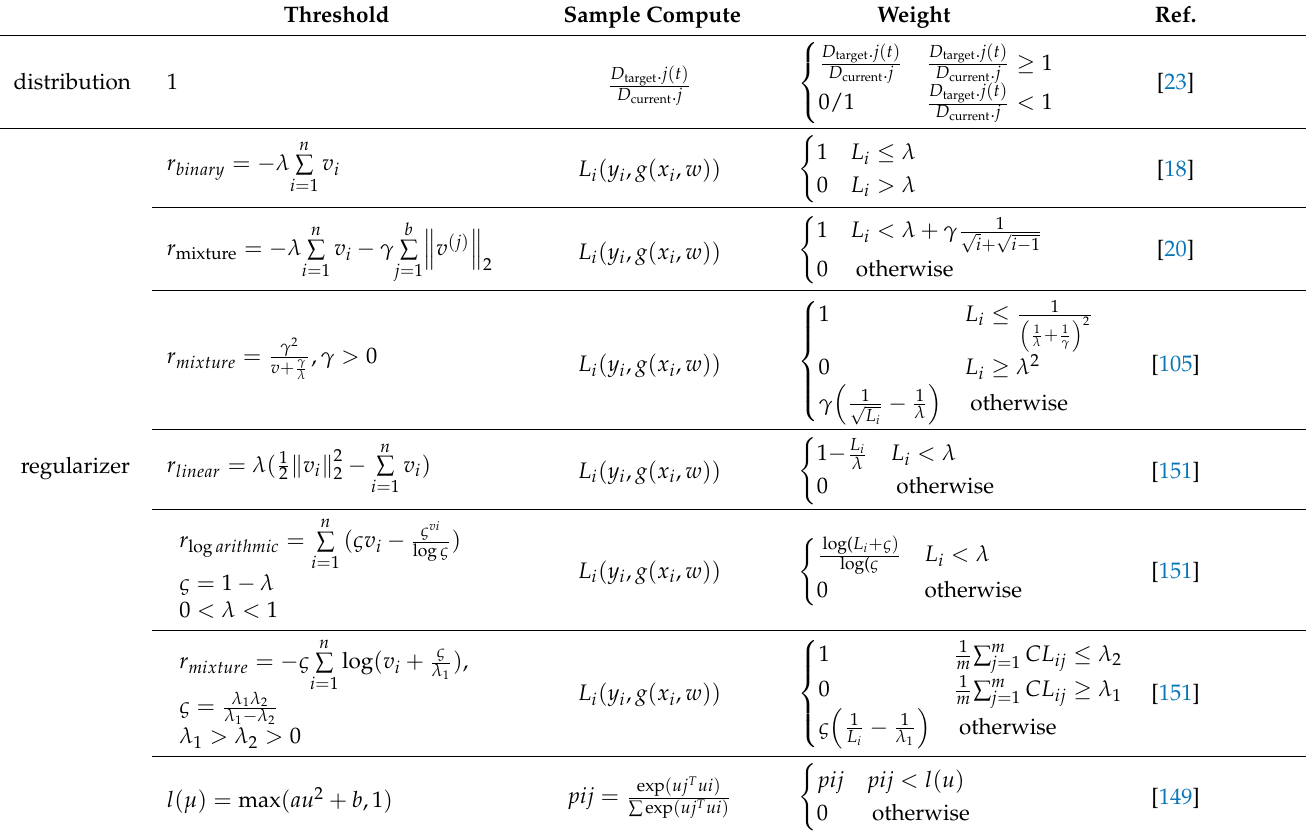
Table 4. Threshold and sample weight assignment